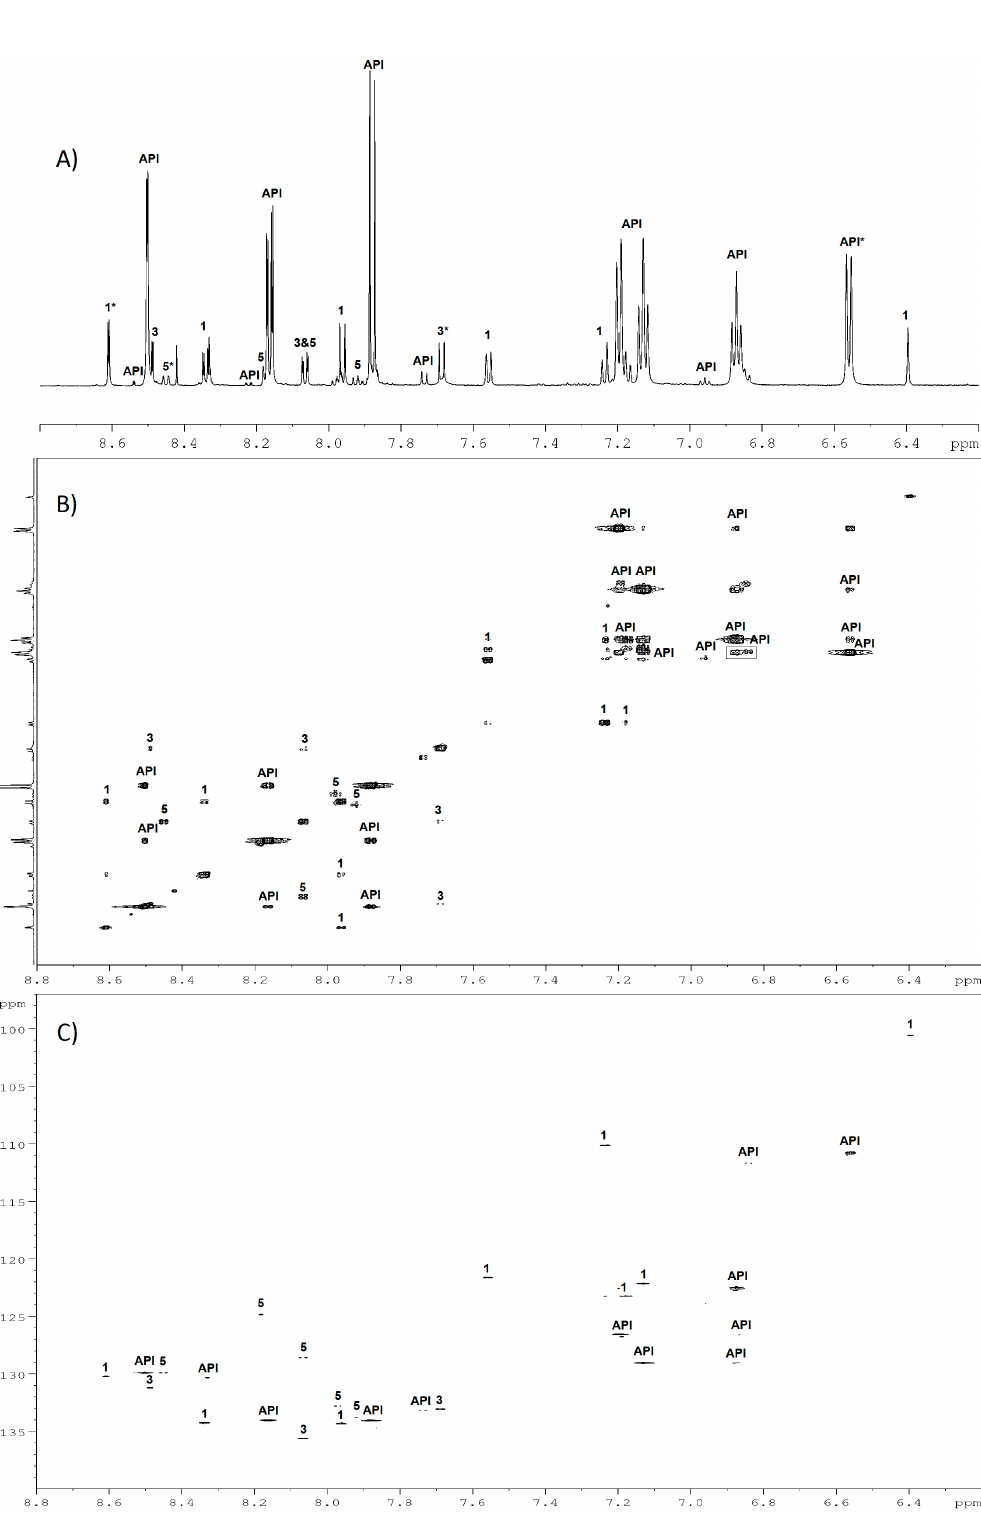
Figure 4. Identification of indapamide, DP1, DP3, and DP5 (labeled API, 1, 3, and 5) using one-dimensional (1D) and two-dimensional (2D)-NMR spectra of the acidic hydrolysis mixture: ( A ) 1 H-NMR; ( B ) 2D-TOCSY; ( C ) 2D-heteronuclear single quantum correlation spectroscopy (HSQC) spectra. (*) corresponds to 1 H selected for the quantification of API and its DPs.